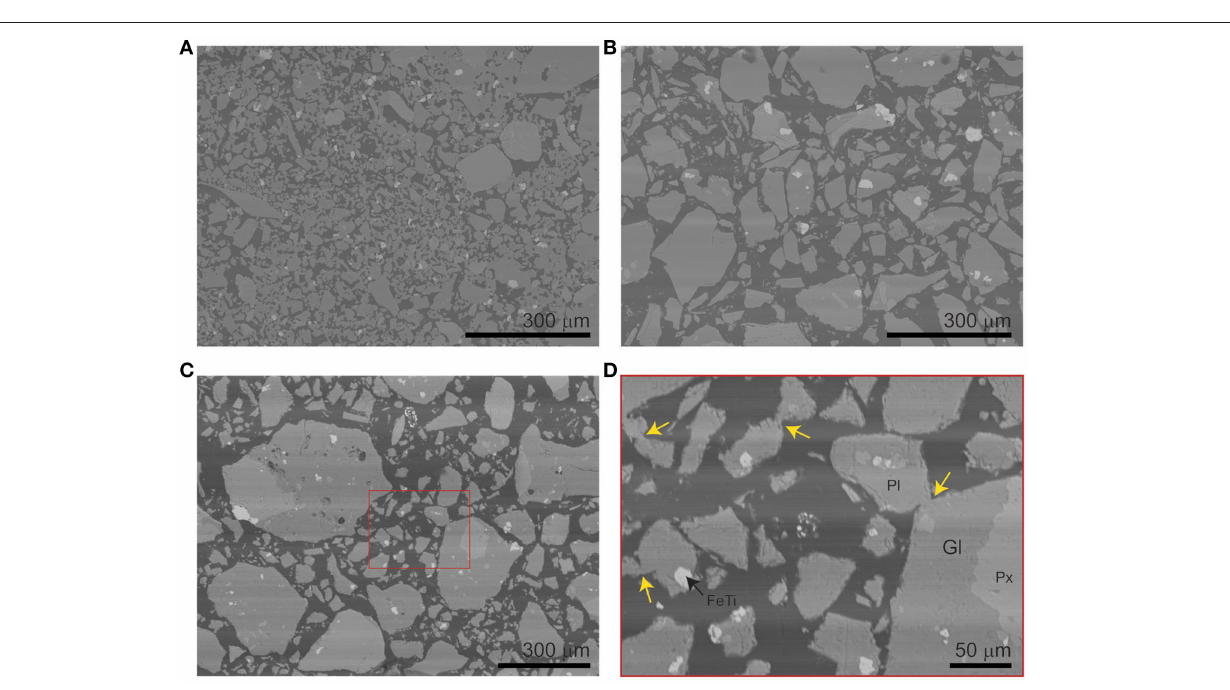
FIGURE 5 | BSE images of natural and experimental samples. (A) Natural tuffisite in a block collected from the Volcán de Colima lava dome on 20th March 2012; (B) The crushed dome lava material used for sintering experiments; (C) The crushed material after sintering for 168h at 940 ◦ C, showing slight rounding relative to the starting material and highlighting area shown in; (D) Closer image of the same sintered sample, highlighting the formation of viscous necks between grains in the interstitial glass (marked by yellow arrows) and with main constituents of the lavas marked: Phenocrysts of pyroxene (Px), iron-titanium oxides (TeTi), and plagioclase (Pl) which is dominant, but difficult to distinguish from interstitial glass (Gl). The 2D section does not allow for a full reconstruction of the sintered particulate network, but sintering is evidently more advanced in the natural material than the experimentally sintered example (D)